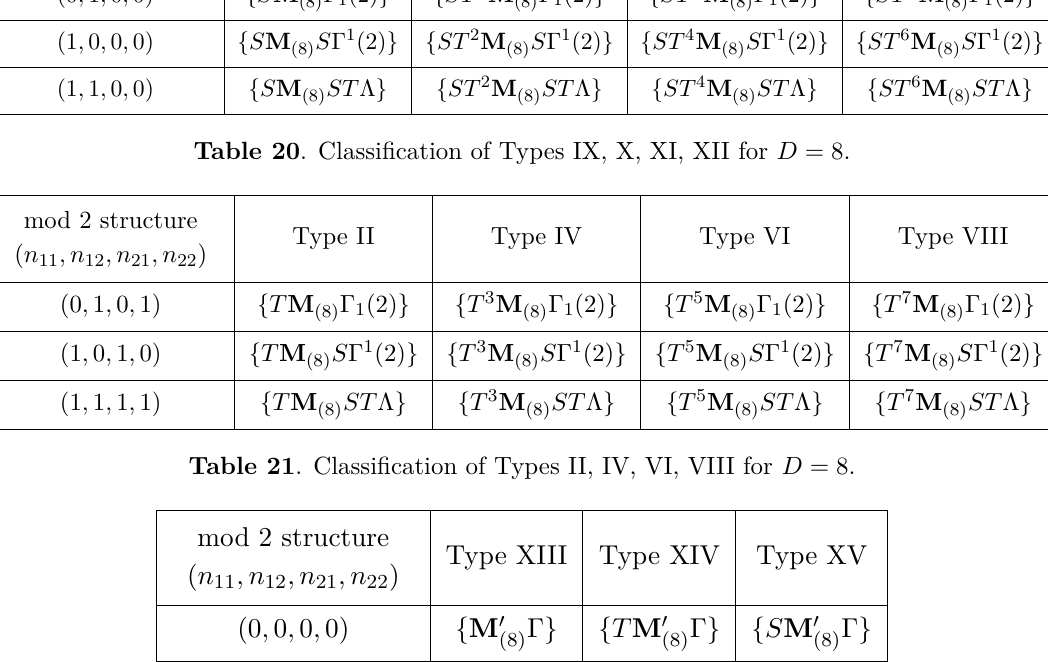
Table 22 . Classification of Types XIII, XIV, XV for D = 8